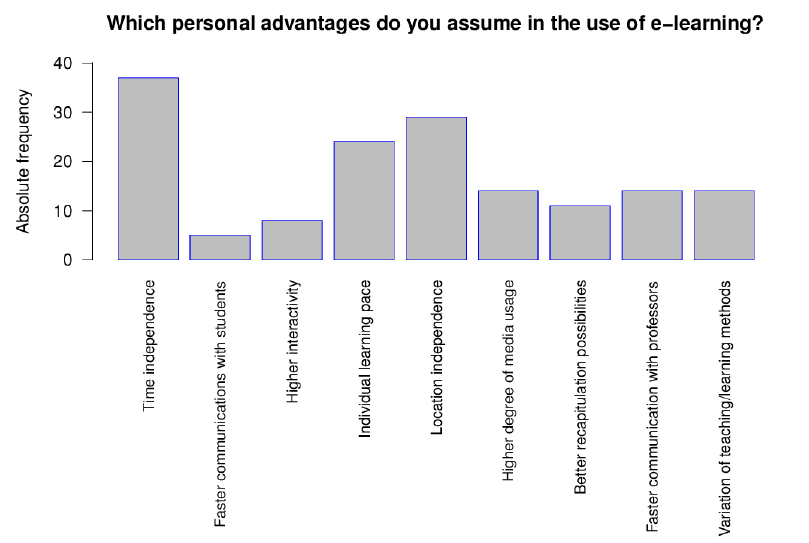
Fig. 6. Evaluation of the advantages the students estimate they will have by using the blended learning course in